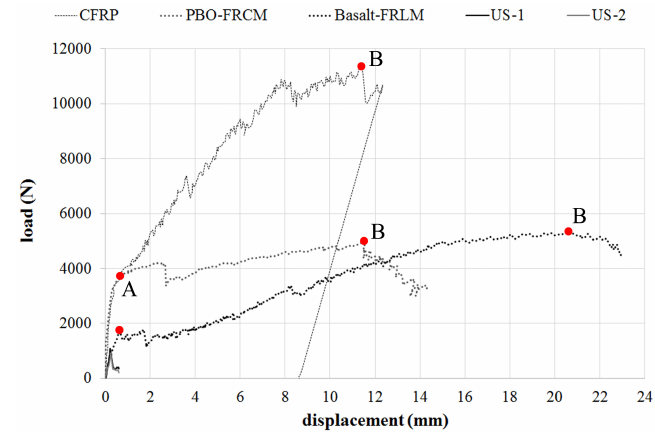
Figure 7. Load ‐ displacement curves of un ‐ strengthened and Basalt ‐ FRLM ‐ , PBO ‐ FRCM ‐ , and CFRP ‐ strengthened arches.